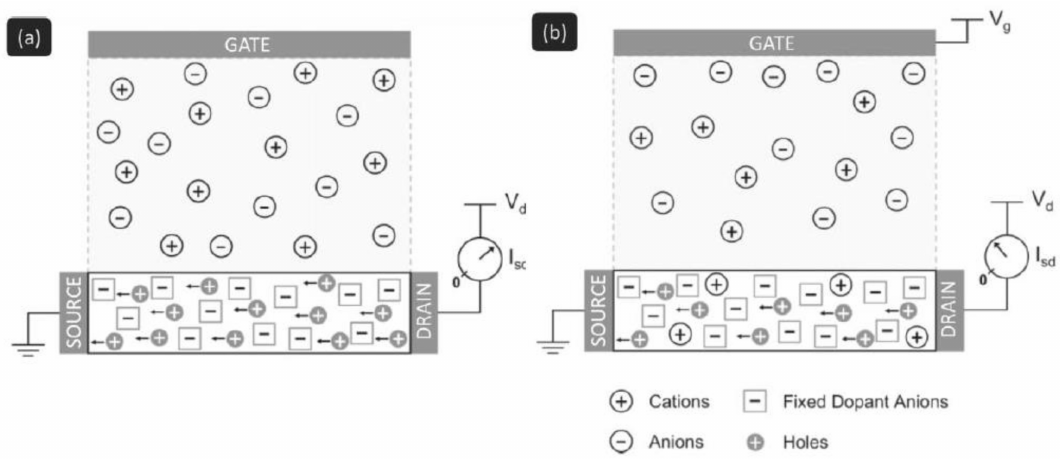
Figure 1. Qualitative OECT functioning mechanism. ( a ) Situation at zero gate voltage. Current flows through the device with respect to the intrinsic conductivity of the p-doped OSC. ( b ) Situation under application of a positive bias to the gate electrode. Cations penetrate in the OSC’s bulk and compensate the dopants’ negative charges resulting in the lowering of the polymer conductivity. Adapted from [30] and reproduced with permission from John Wiley and Sons, Copyright ©